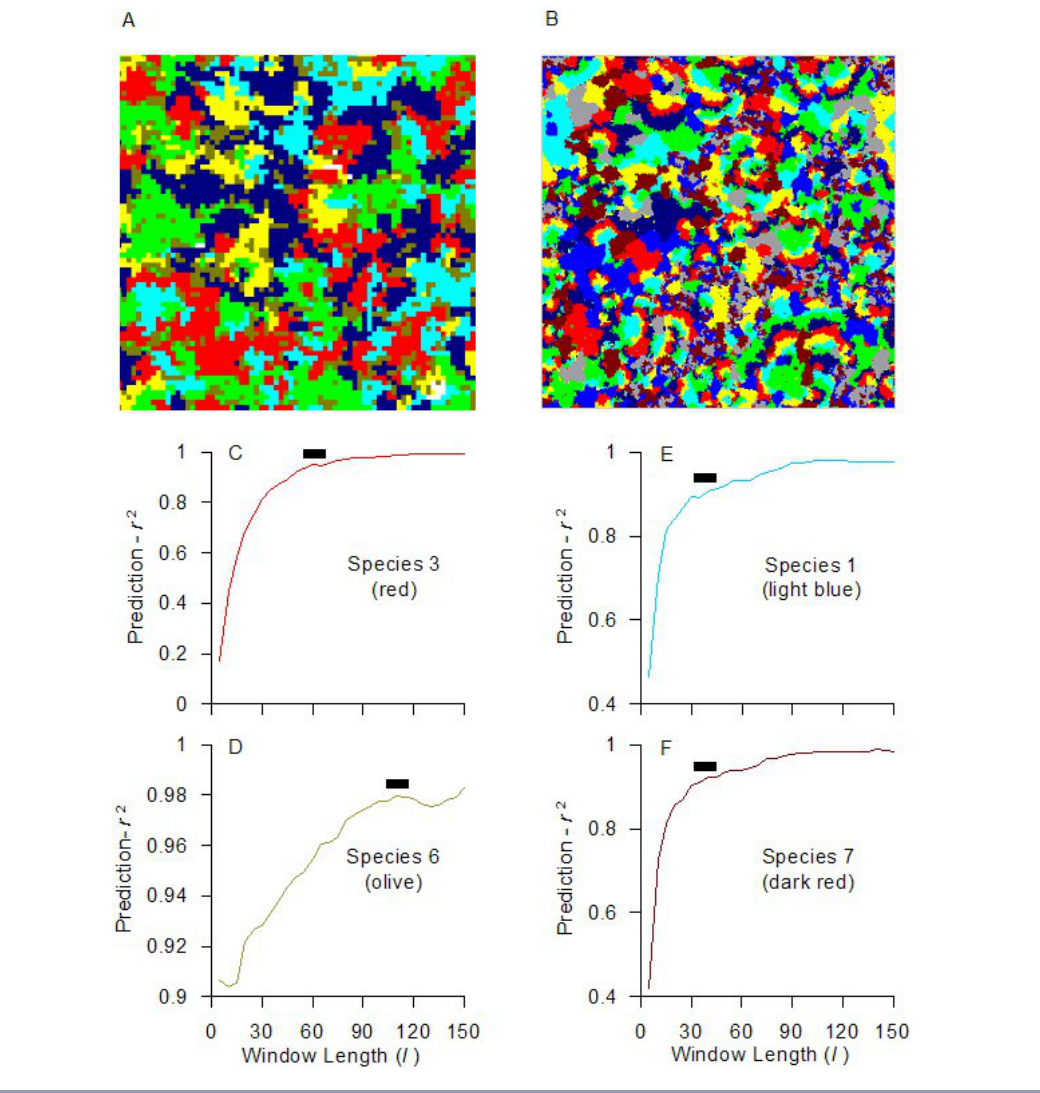
Fig. 7. The effect of connectivity among species on the CLS, showing that poorly connected species can indicate dissimilar length scales. In one example (A,C,D) there are six species, comprising five species that interact strongly, but where encounters with a 6th species are all standoffs. All species are able to recruit to bare patches (= white) on the landscape (see Methods). In the other example (B,E,F), there are eight species, where S –S interact strongly, and S –S interact strongly, but all interactions between S – 1 5 6 8 1 S and S –S are standoffs (see Methods). (A) shows a magnified portion of the landscape whereas (B) 5 6 8 shows the full 300 x 300 landscape (both at 5000 generations). Species colors for S –S are as in Fig 2. 1 5 In A and D, S = olive; in B and F, S = deep blue, S = dark red, and S = gray. Prediction-r 2 spectra are 6 6 7 8 shown for analyses based on series of six maps, each 10 time steps apart, finishing at generation 5000. In the six-species example, the CLS indicated by S –S (about 65 length units) is less than that indicated 1 5 by S (about 115 length units). In the eight-species example, the CLS indicated by S – S is similar to 6 1 5 that indicated by S –S (about 35 length 6 8